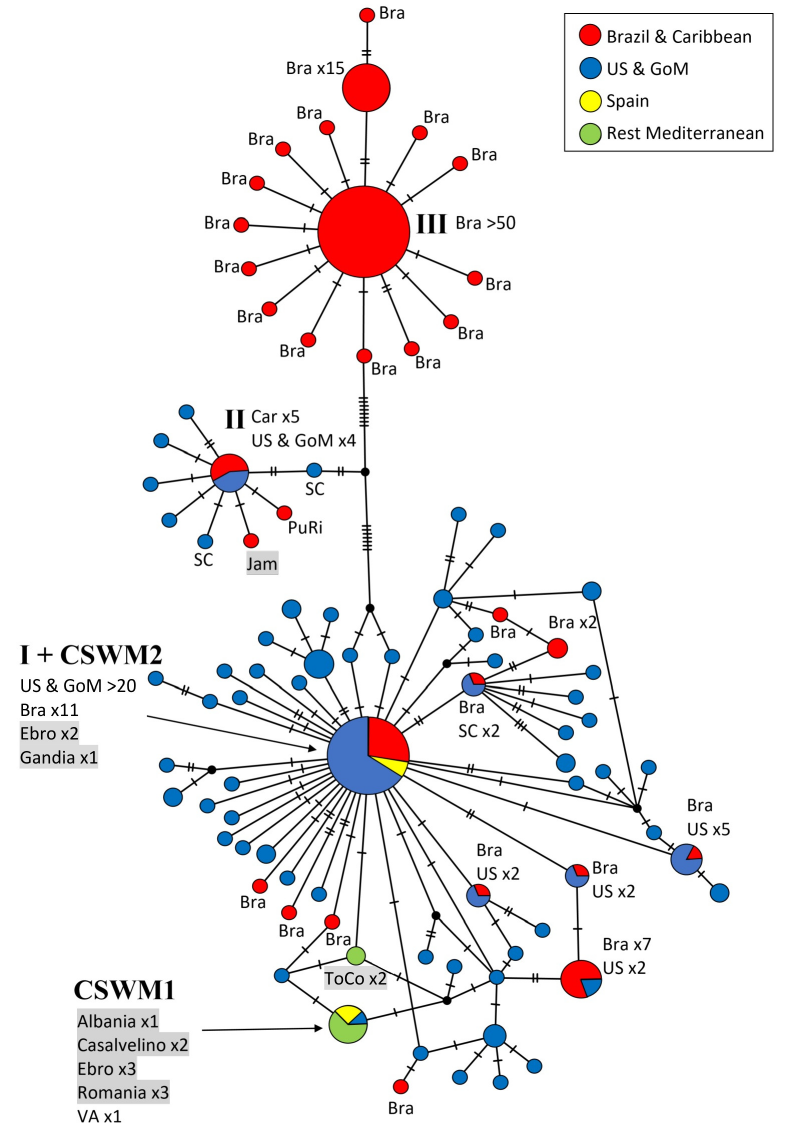
Figure 3. Maximum parsimony network showing genetic distances among 248 sequences of Callinectes sapidus corresponding to the ‘Palumbi region’ of COI (640 bp; 16 current study, 232 GenBank), constructed with TCS (Popart vers. 1.7). Diameters of the circles correspond to the frequencies of the respective haplotypes. The numbers of dashes display mutational steps (each dash stands for one single nucleotide mutation). Small black circles represent hypothetical (missing) haplotypes. Sample locations are represented by colors, with the North American lineage in blue, South American and Caribbean lineages in red, Spain in yellow, and the remaining Mediterranean Sea in green. Self-generated sequences are shown as grey fields. Abbreviations: Bra = Brazil, Car = Caribbean Sea, GoM = Gulf of Mexico, Jam = Jamaica, Mex = Mexico, PuRi = Puerto Rico, ToCo = Torre Colimena, Ven = Venezuela; SC = South Carolina, VA = Virginia. Numbered haplotypes: I = most common North American haplotype, including European and Brazilian specimens; II = most common Caribbean haplotype; III = most common Brazilian haplotype.